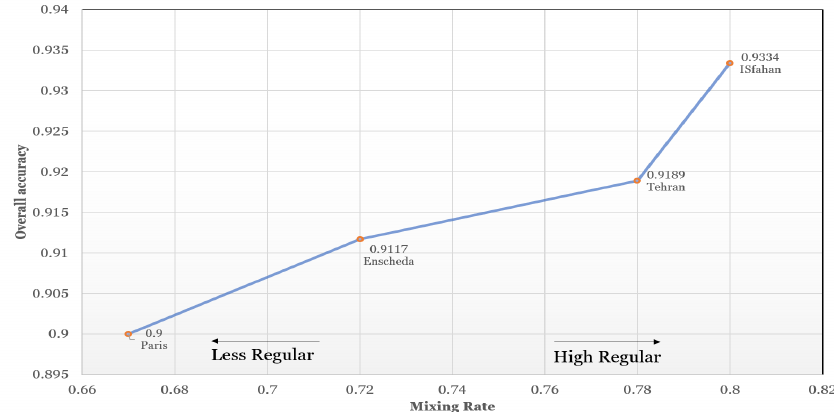
Figure 6. The mixing rate of cities’ regularity versus SDAE overall